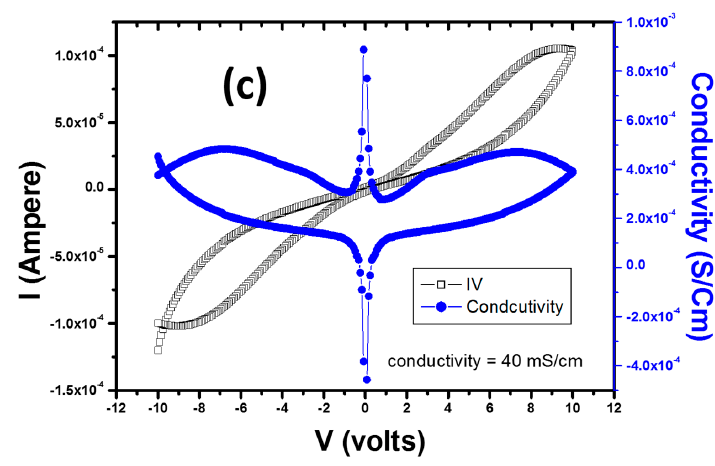
Figure 10. I–V curves of ( a ) PS/AgNP; ( b ) PMMA/Ag; and ( c ) PSMMA/Ag nanocomposites.